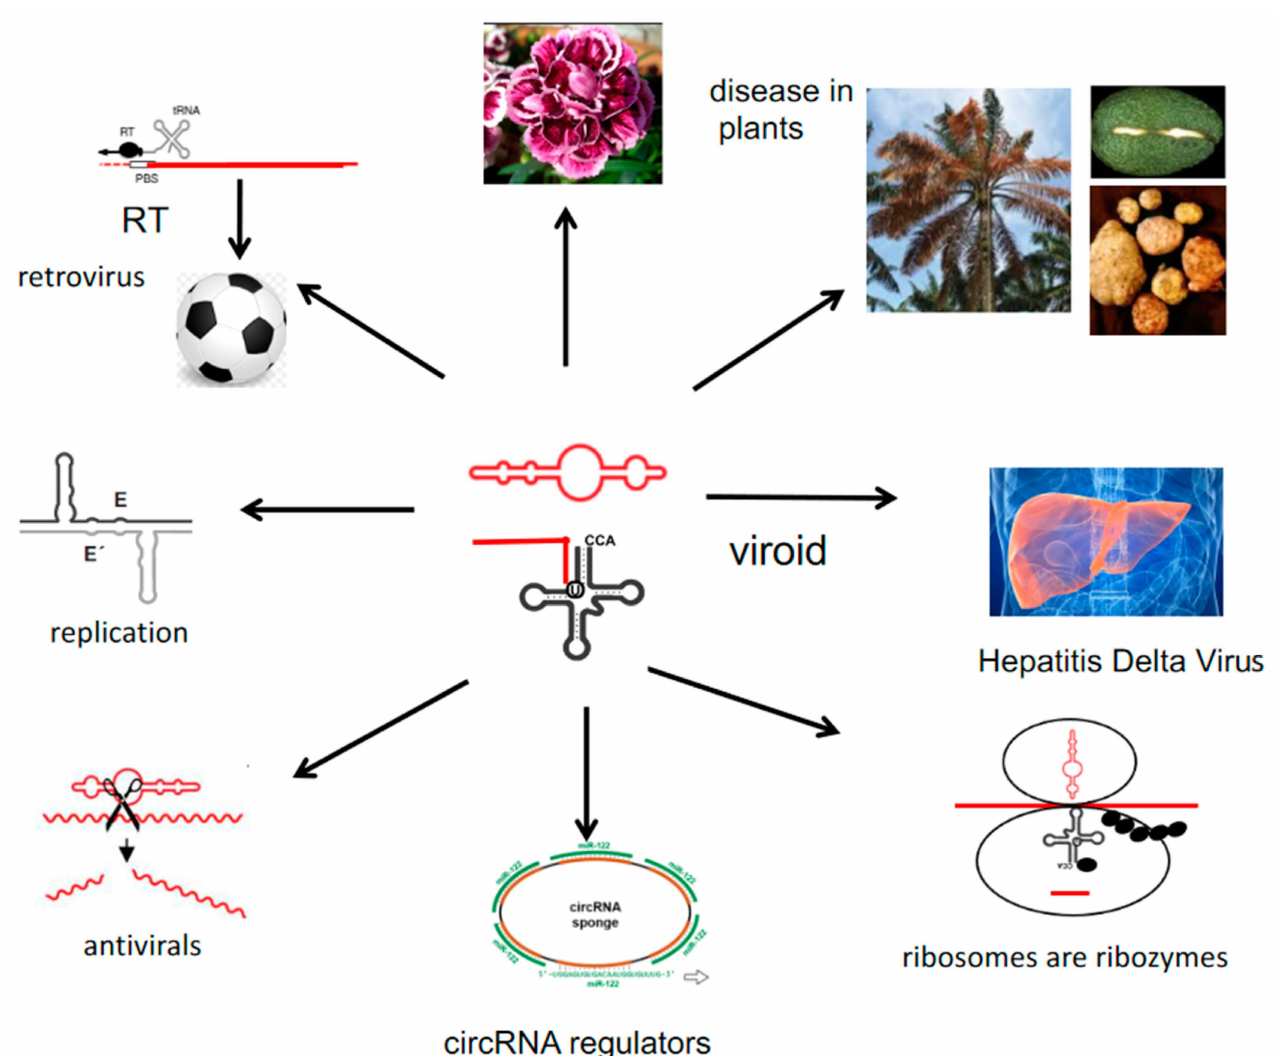
Figure 2. Multifunctionality of viroid-like RNA. Viroids/ribozymes and the ribozyme RNase P shown in the center, contribute to many phenomena, to diseases in plants such as palm trees, potatoes and avocado, to the human hepatitis delta virus, to protein synthesis in ribosomes, to regulatory circular RNAs, a chief-regulator, which regulates the levels of micro RNAs (miR), and to hammerhead ribozymes, symbolized as scissors, for gene therapy against cancer. Ribozymes can replicate in the test tube as shown in the model. The tRNA may be as ancient as the viroid and contributes to retrovirus replication. RT is the Reverse Transcriptase, which requires protein synthesis. The football symbolizes a retrovirus icosahedron. Carnations owe their pattern to a viroid and a para-retrovirus from plants (For details, see text) (RNA in red